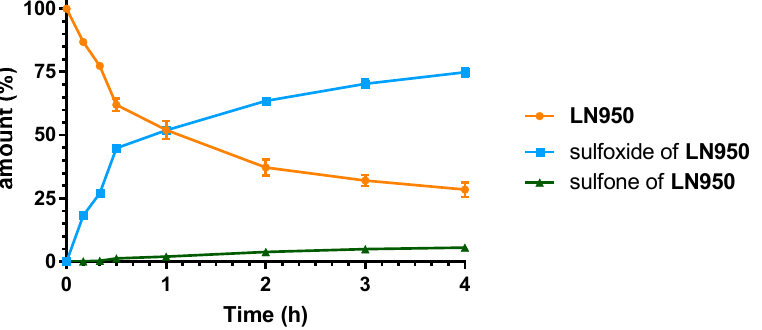
Figure 5. Metabolic stability of LN950 and the formation of main metabolites (sulfoxide and sulfone of LN950 ).